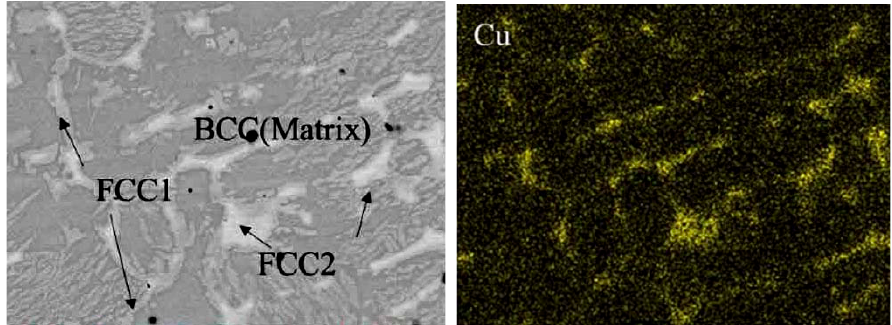
Figure 10. ( left ) SEM micrograph of the plasma cladded Fe 19.49 Co 19.49 Ni 19.49 Al 19.49 Cu 19.49 Si 2.55 (at.%) HEA coating. ( right ) EDS map of copper. Micrographs are reprinted with permission from ref. [96]. Copyright 2017 Elsevier.